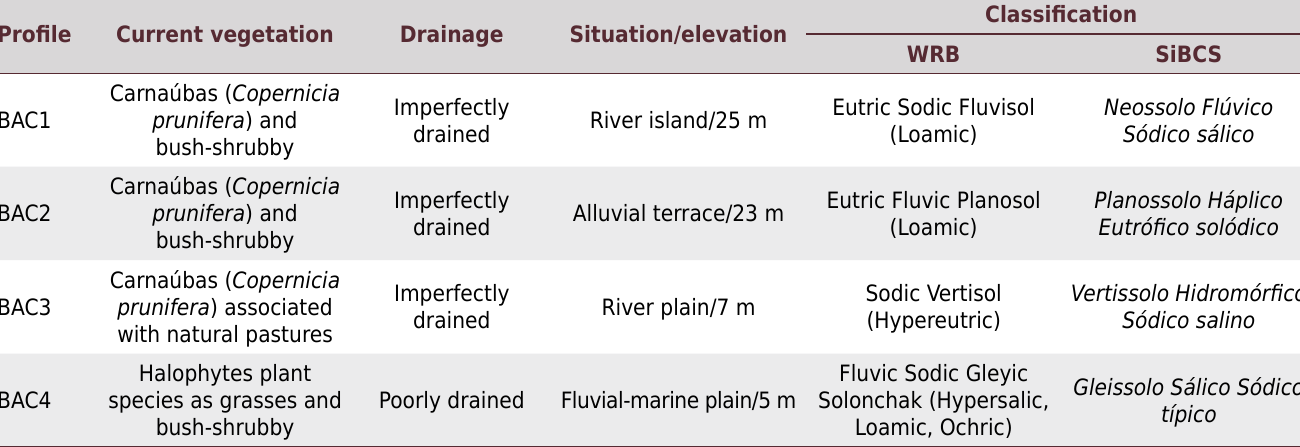
Table 1. General information and classification regarding soil profiles of the lower course of the Acaraú River (Ceará State, Brazil)